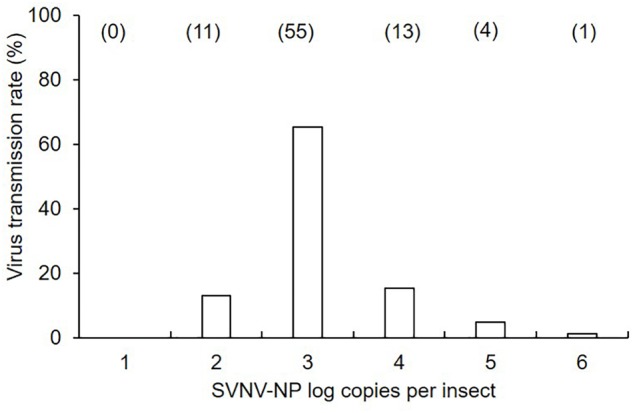
Mean of soybean vein necrosis virus log copies in N. variabilis adults that exhibited successful virus transmission in leaf-disk assays. The number of SVNV-NP RNA in individual adults was categorized into each order from < 101 to 106. Numbers in parentheses above each bar represent the number of N. variabilis in each virus titer category. Transmission rate was calculated by dividing the number of individuals per category by total number of positive insects (n = 84).